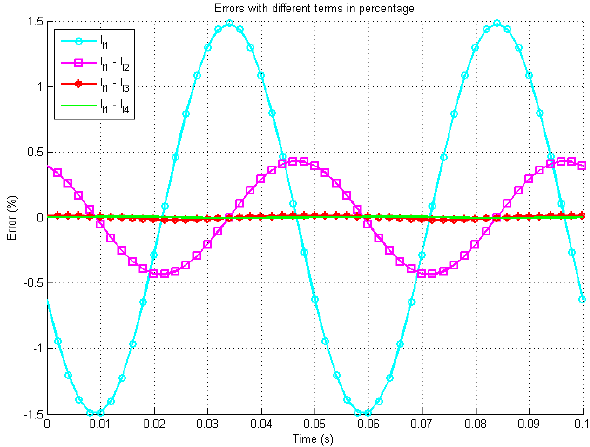
Figure 5. Simulation errors between the Simulink solution and the iterative solution by percentage.